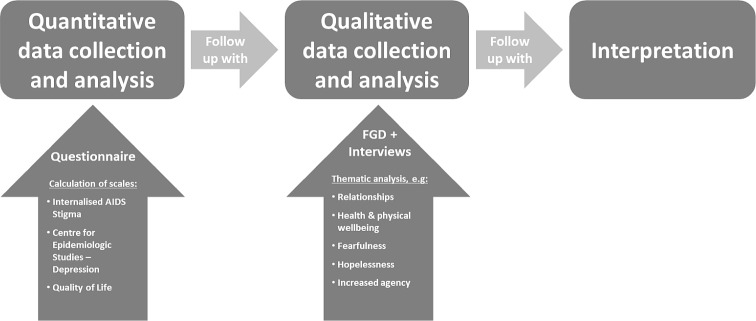
Sequential mixed methods study design.Initial data collection and analysis of quantitative scales was carried out using a questionnaire delivered to participants, incorporating items from the Internalised AIDS Stigma scale; Centre for Epidemiologic Studies–Depression scale; and HIV/AIDS Targeted Quality of Life Scale. This was followed by qualitative data collection and thematic analysis from Focus Group Discussions and one-on-one Interviews.